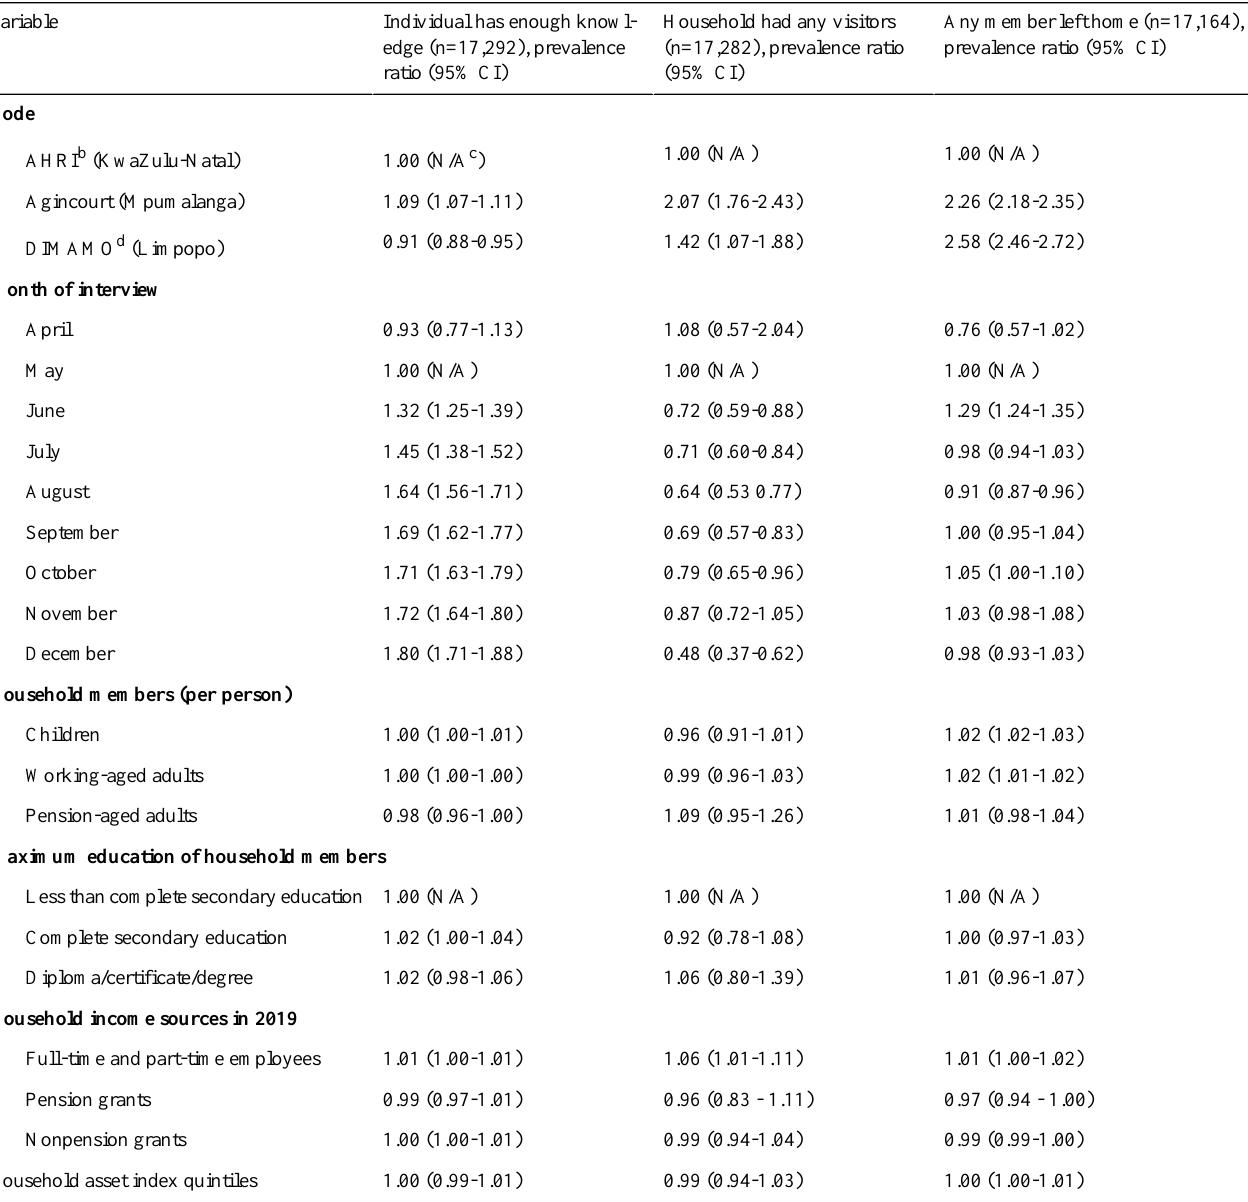
Table 2. COVID-19–related knowledge and home behaviors in South Africa from April to August 2020 a .